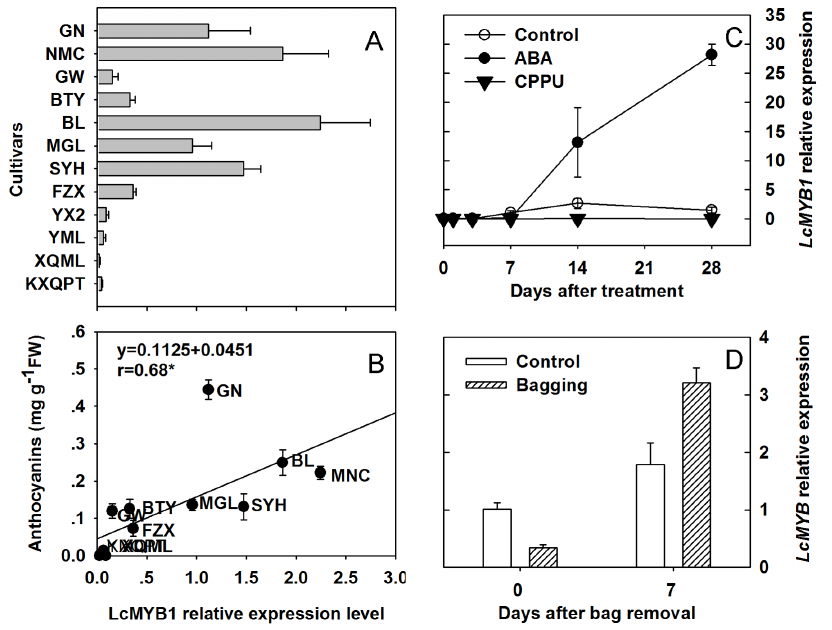
Figure 4. LcMYB1 expression in the pericarp of different cultivars and manipulation treatments. A, LcMYB1 expression of in the pericarp of twelve cultivars. B, The correlationship between LcMYB1 expression and anthocyanin content among the twelve cultivars. Anthocyanin contents were obtained from Wei et al. [7], Effects of ABA and CPPU on the expression of LcMYB1 . D, Effects of bagging and bag removal on LcMYB1 expression.